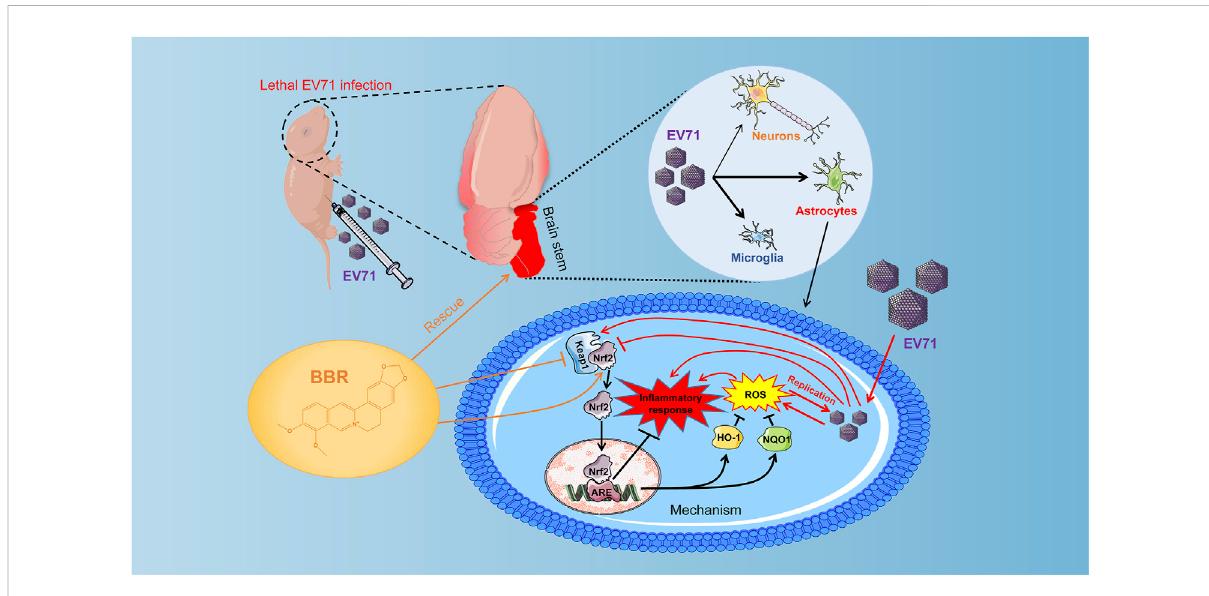
Effect and mechanisms of BBR against lethal EV71 neurological infection. EV71 infection was localized predominantly in the brainstem in the newbornmousemodel. BBRpreventslethalEV71neurologicalinfection via inhibitingvirusreplication mainlyinglialcells.BBRinhibitsEV71-induced upregulation of Keap1, thereby enhances the expression and nuclear translocation of Nrf2, promotes expression of antioxidant enzymes HO-1 and NQO1, abolishes elevated ROS production, virus replication and in fl ammatory injury in the